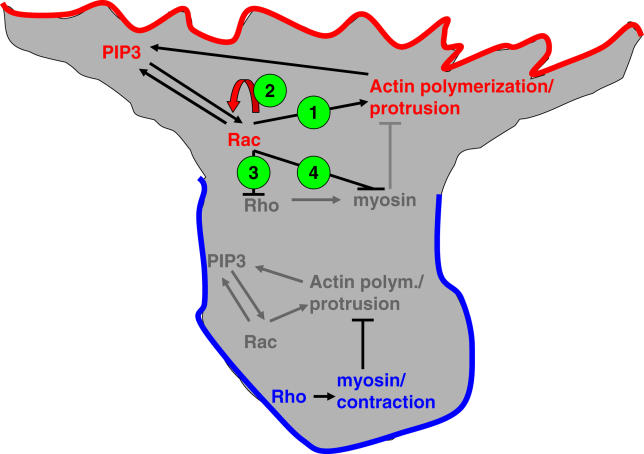
Role of Leading Edge Complexes in Cell PolarityMigrating cells make different actin assemblies in the front and back. The leading and trailing edges of the cell are organized by different GTPases. Rac plays a role in two positive feedback circuits that organize the leading edge and drive stable protrusion (we call this nested feedback circuit Rac/actin/PIP3 positive feedback). A separate GTPase (Rho) organizes myosin-based contraction at the trailing edge, primarily through inactivation of myosin light chain phosphatase, leading to local phosphorylation and activation of myosin light chain. Several positive and negative feedback circuits are essential for the proper organization of cell polarity, but not all of the proteins involved in these circuits are known. In this paper, we discuss several leading edge protein complexes that play a role in organizing of the leading edge. These leading edge complexes link Rac with actin assembly (Activity 1) and play a role in a Rac positive feedback circuit (Activity 2), both essential elements of the positive feedback loop that organizes the leading edge. Leading edge complexes also potentially link Rac to the inhibition of Rho activity (Activity 3) and inhibition of myosin activation (Activity 4), both of which would act to exclude myosin phosphorylation from the leading edge. For simplicity, this model focuses on activities that are addressed in this paper and omits other possible links involved in Rac/actin/PIP3 positive feedback and from Rac to Rho and myosin.